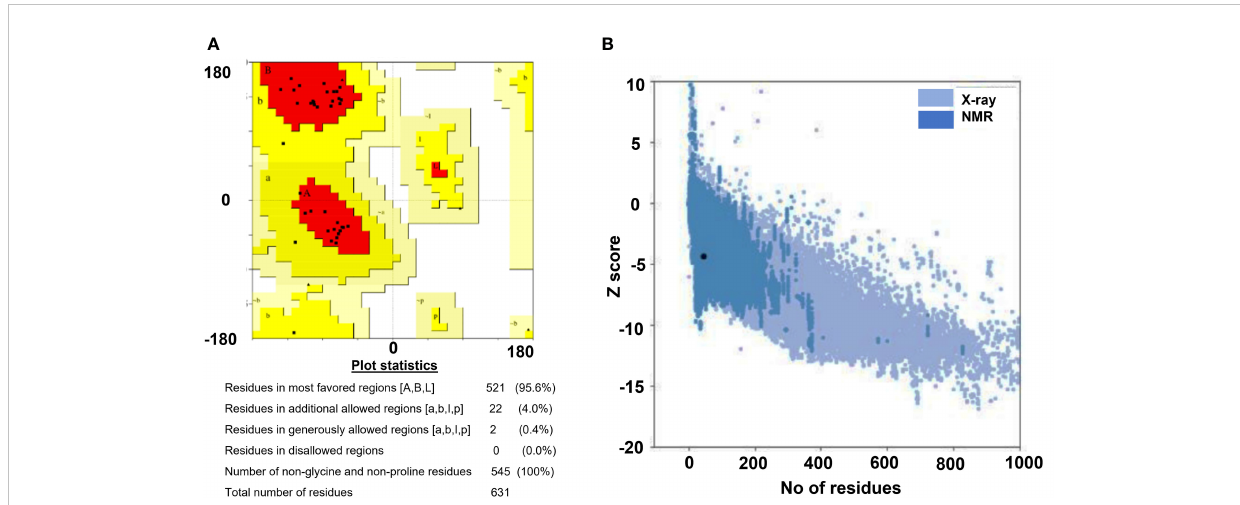
FIGURE 2 Tertiary strucutre validation results for the designed construct (V7). (A) Ramachandran plot, (B) ProSA web